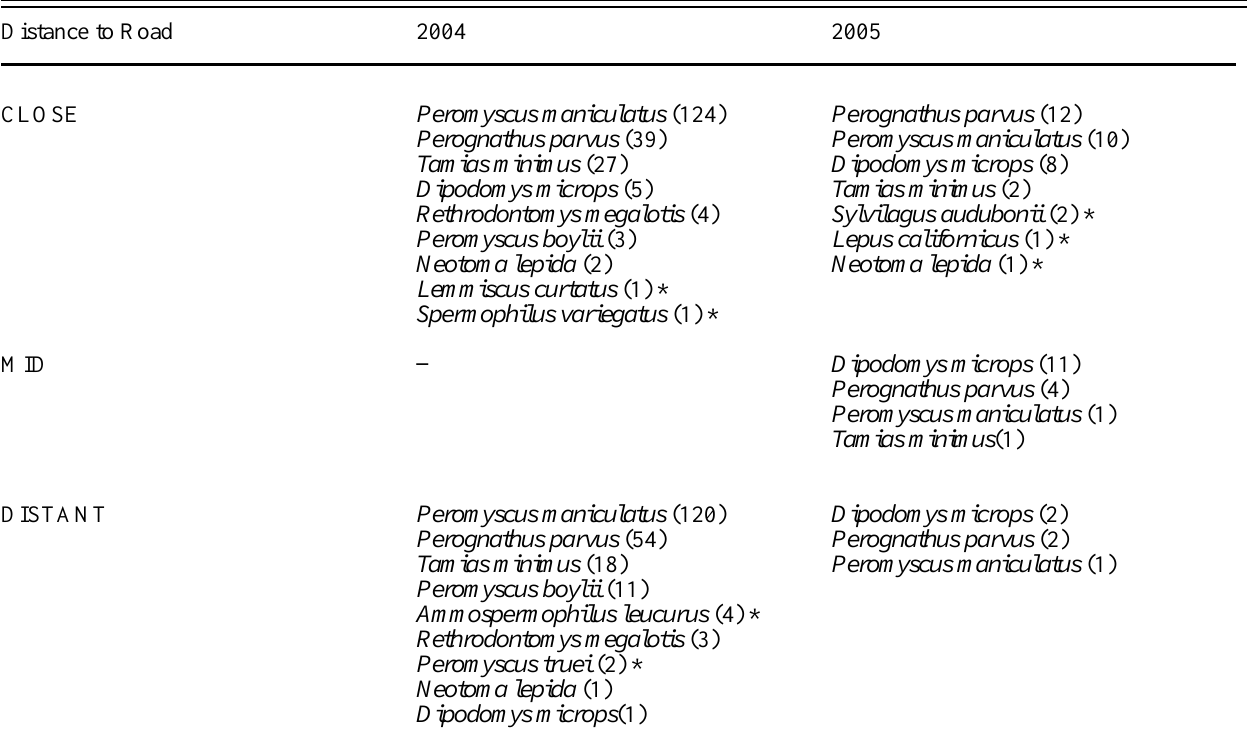
Table 1. Species detected at different distances from the I-15 in 2004 and 2005 in southern Utah, USA; number of individual captures of each